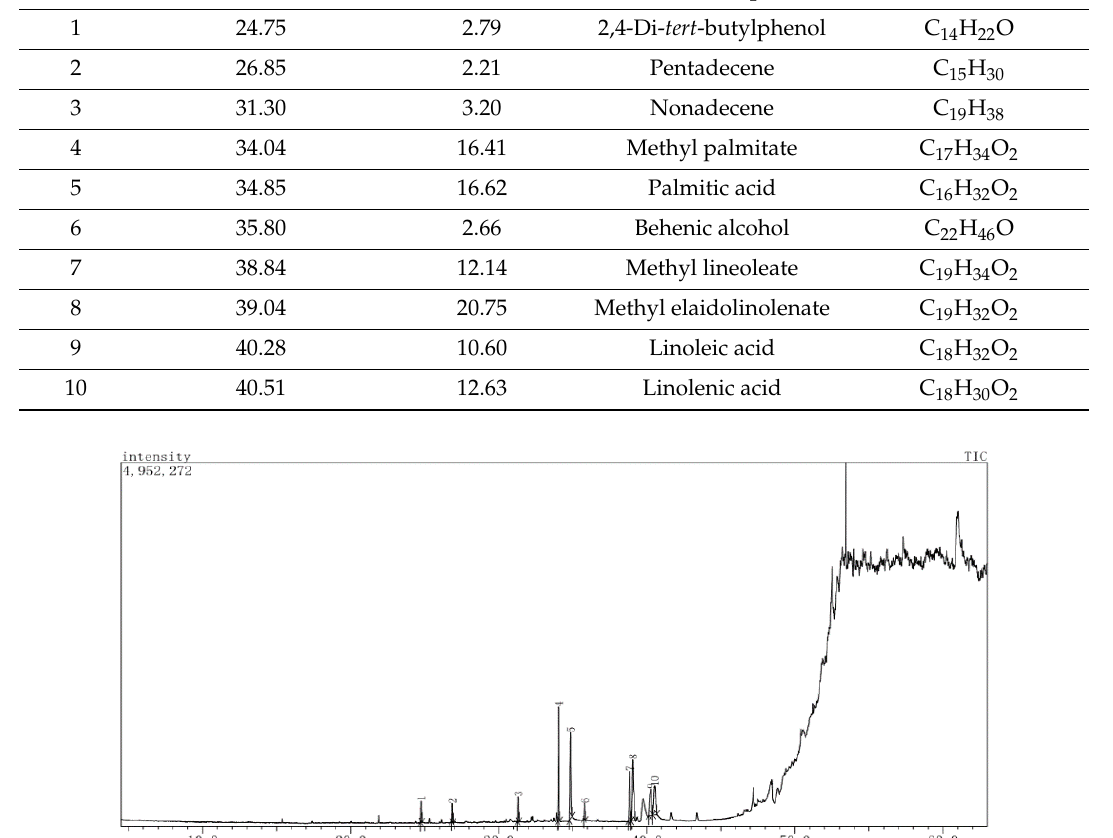
Figure 1. Total ion chromatogram (TIC) of dichloromethane (DTL) extract of T. leucostaphylum . Table 1. List of chemical compounds in the dichloromethane (DTL) extract of T. leucostaphylum , identified by GC-MS.